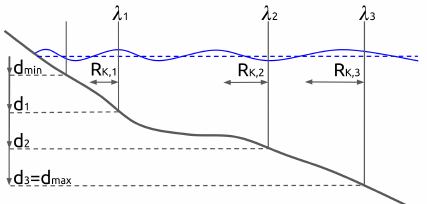
Figure 8. Depths d j and wavelengths λ j for R K, j .